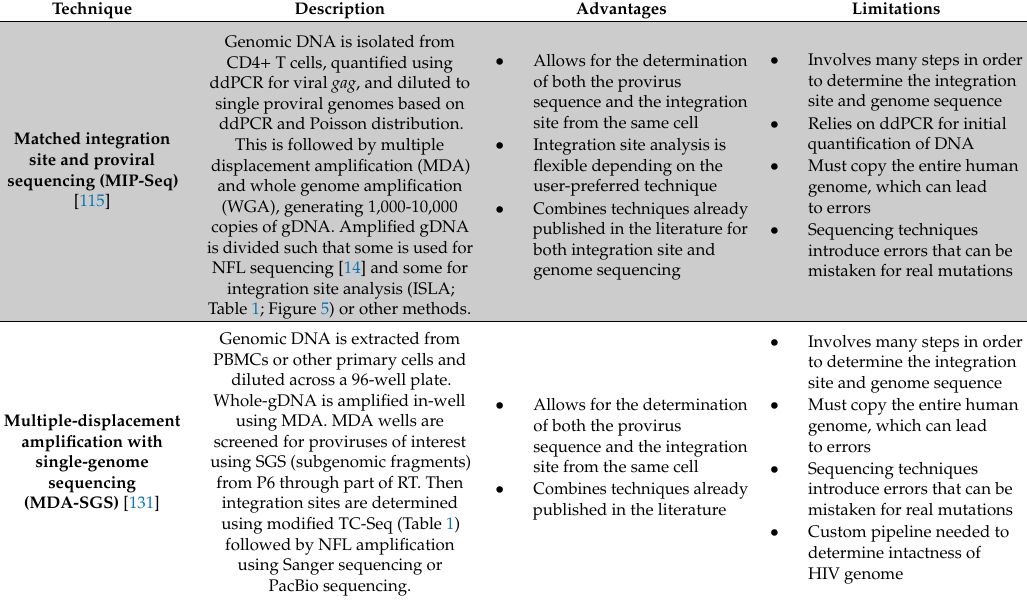
Table 3. Combined genome amplification and integration site